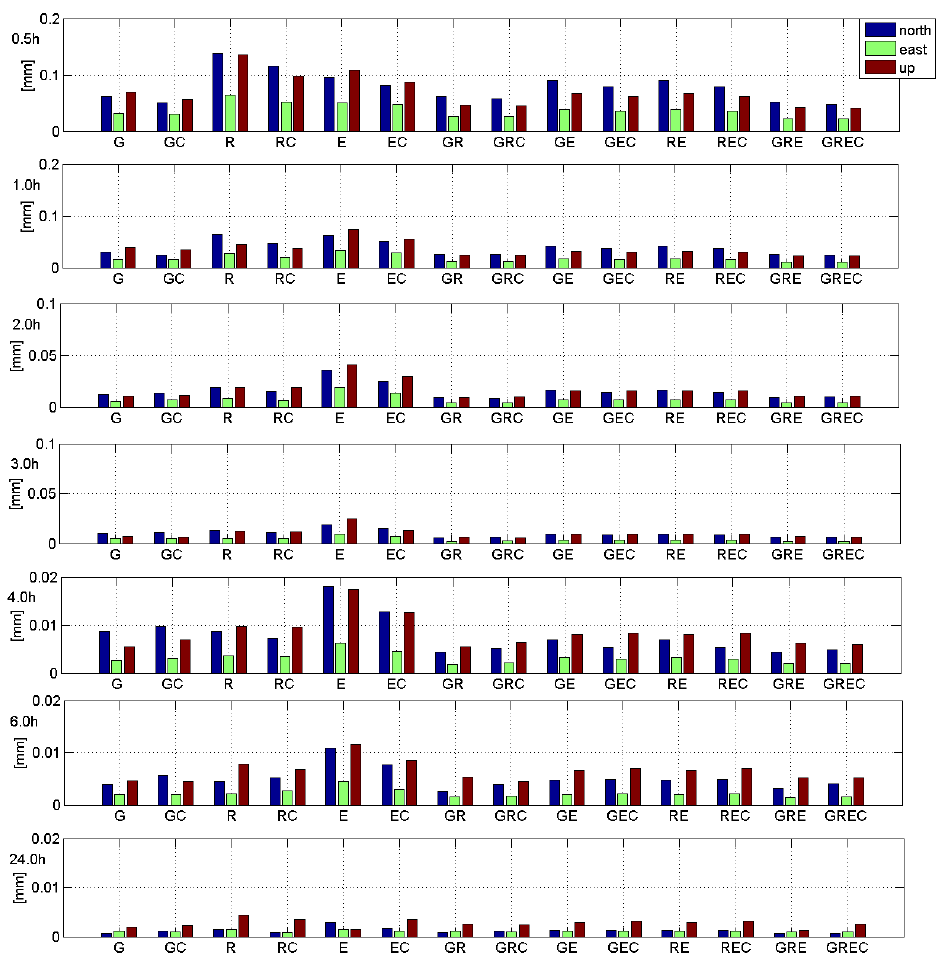
Figure 8. Standard deviation for the position components differences time series: from 0.5 hour ses- sion to 24 hours session. Please note three different scales on vertical axis.